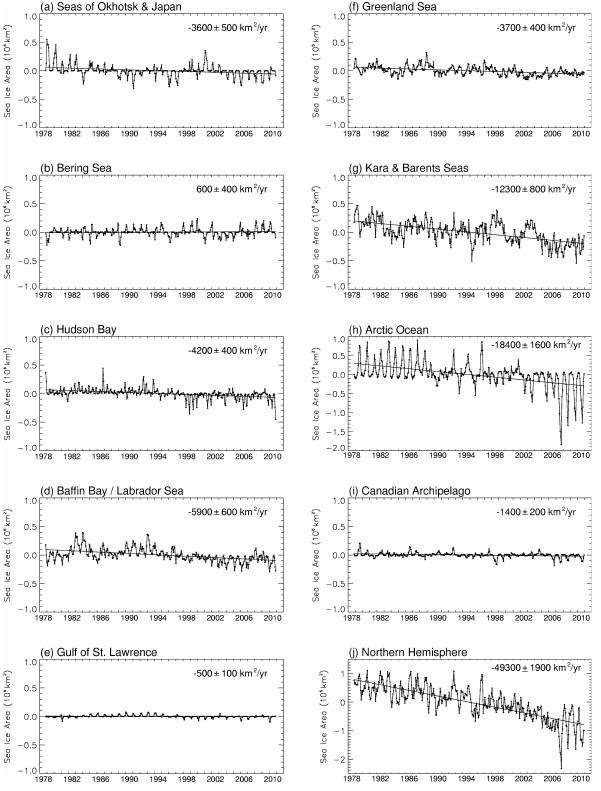
Fig. 7. Sea ice area trends by month over the 32-yr period 1979– 2010 for (a) Seas of Okhotsk and Japan, (b) Bering Sea, (c) Hud- son Bay, (d) Baffin Bay/Labrador Sea, (e) Gulf of St. Lawrence, (f) Greenland Sea, (g) Kara and Barents Seas, (h) Arctic Ocean, (i) Canadian Archipelago, and (j) Northern